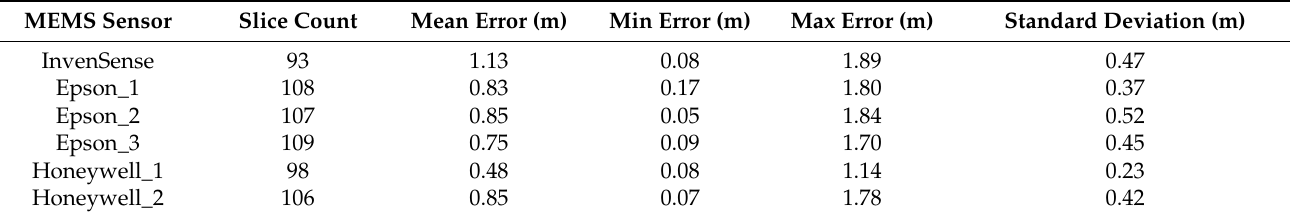
Table 3. Accuracy statistics—5 s slice length.